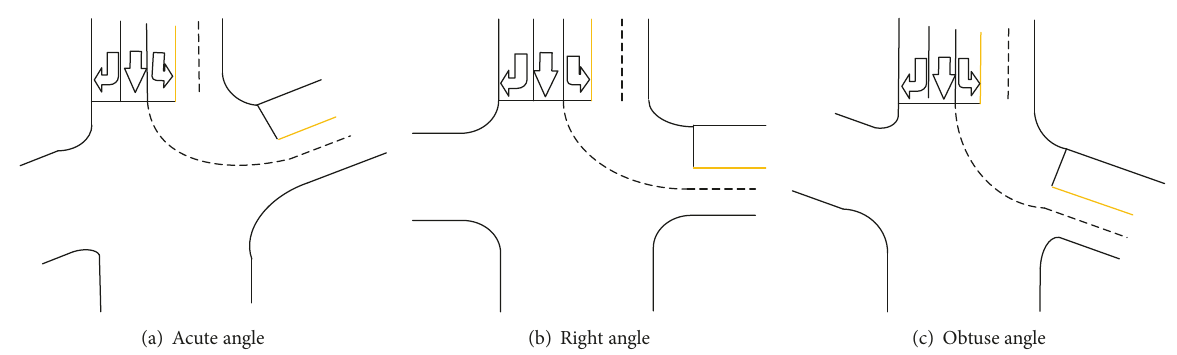
Figure 3: Left-turn angle